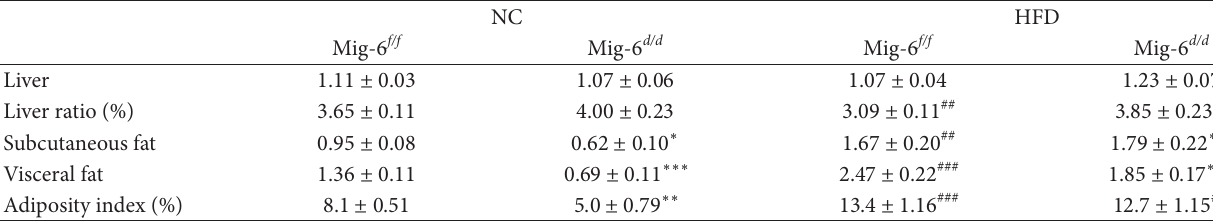
Table 2: The organ weights of Mig-6 f/f and Mig-6 d/d